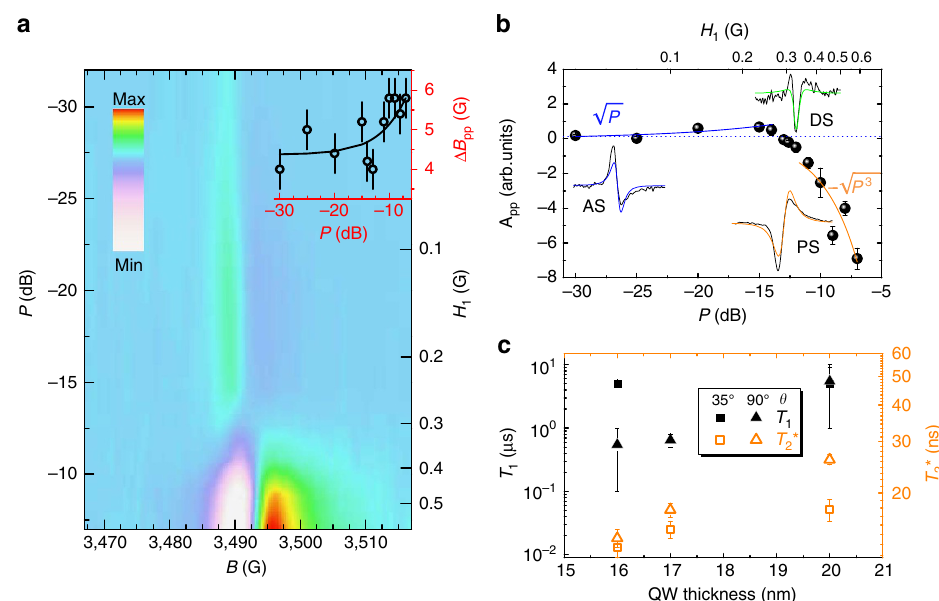
Figure 5 | CESR power dependence and spin-relaxation times. ( a ) Colour-coded intensity map of the CESR peak at g ¼ g t and y ¼ 90 (cid:2) in 17nm Ge QWs, as a function of the microwave power ( P ). The scale bar indicates the ESR signal intensity. H 1 is the intensity of the magnetic field of the microwave within the sample. Inset: D B pp of the CESR peaks versus P (dots) and fit (solid line) according to ref. 56. The error bars are derived from the least squares fit analysis of the lineshape of the spectrum. ( b ) Peak-to-peak amplitude ( A pp ) of the peaks shown in a versus P . The blue and orange solid lines are guides to the eye. The shape of the peak at (cid:3) 30, (cid:3) 12.5 and (cid:3) 7dB are reported (black lines) together with the fitting curves (coloured lines) showing absorption (AS), dispersion (DS) and polarization (PS) components 56 , respectively. A pp is considered positive when the ESR peak is AS-like, and negative when it is PS-like. The error bars are derived from the least squares fit analysis of the lineshape of the spectrum. ( c ) Values of spin-lattice relaxation time T 1 and ensemble dephasing time T (cid:7) obtained from ESR peaks at g ¼ g t in QWs with different thickness. The error bars are derived from the least squares fitting 2 analysis based on the model of ref. 56 of the data set measured at different microwave